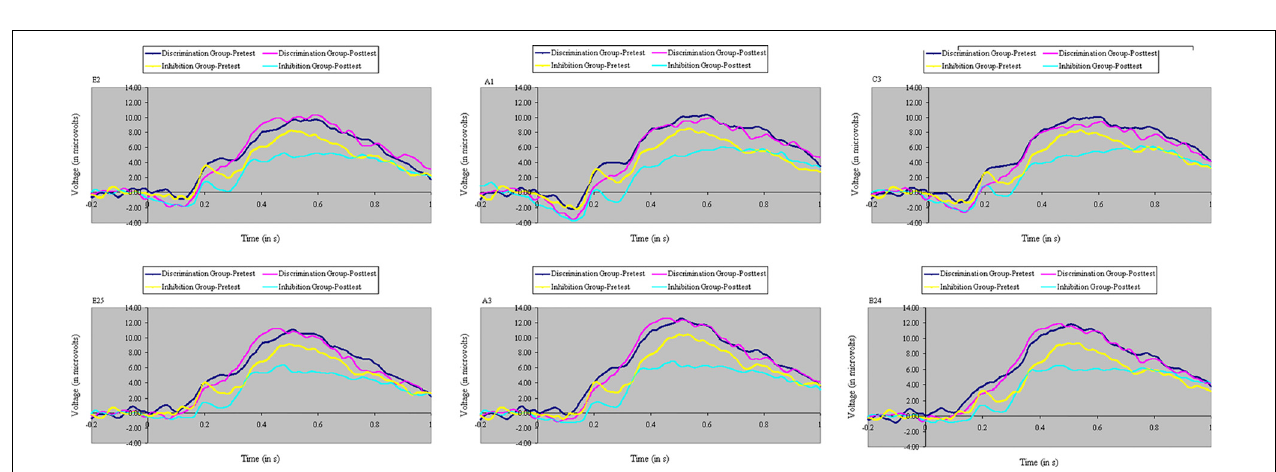
FIGURE 9 | Amplitude of P3 ERP component to distractors (in microvolts) on congruent and incongruent trials in the filtering task at pretest and posttest in discrimination and inhibition training groups. The distinct effects of inhibition or discrimination training on distractor P3 were mainly relegated to incongruent stimuli, yielding a significant three-way interaction of Training, Group, and Congruity.